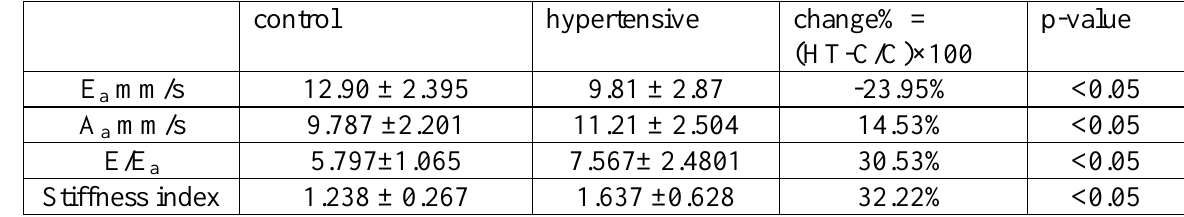
Table 2:- Doppler Tissue Imaging Annular